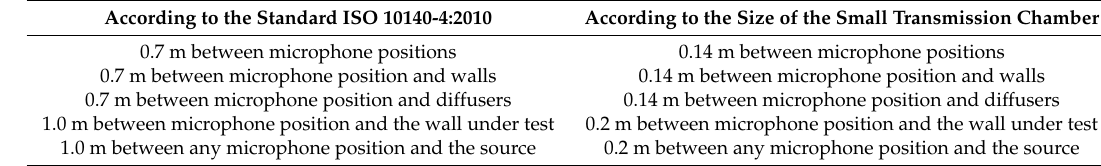
Table 2. Minimum separation distances to comply with in the reduced sized transmission chamber. According to the Standard ISO 10140-4:2010 According to the Size of the Small Transmission According to the Standard According to the Size of the Small ISO 10140-4:2010 Transmission Chamber.